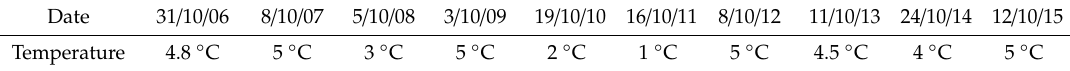
Figure 2. Left y -axis: mean number of young females of Parthenolecanium corni per vine, from 2003 to 2015 in the Riesling plot in Nothalten. Right y -axis: Extreme minimal --- and maximal ______ temperatures (in °C) recorded in Kintzheim (12 km south of the study plot). Table 1. Dates of first temperature ≤ 5 ◦ C in October during the survey of Parthenolecanium corni female